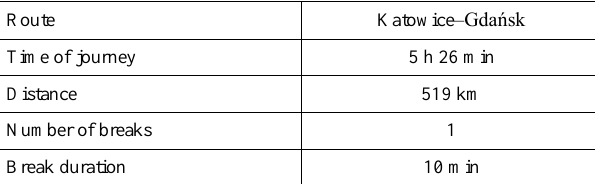
Table 9. Route details generated for ICE vehicle in [8]